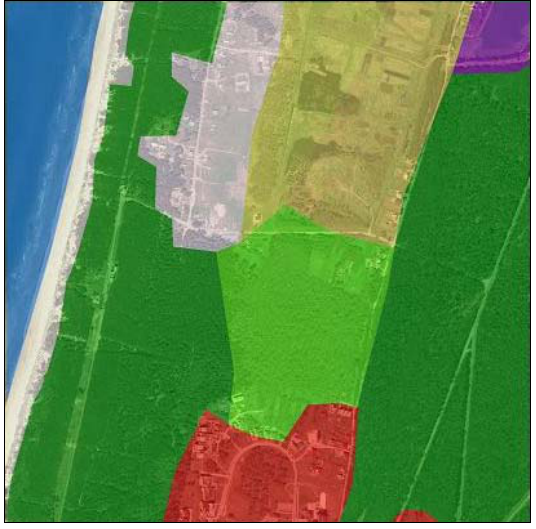
Fig. 6. The patchiest sample (No 96) selected from river valley landscape type (17 land cover patches, 7 types, located in Utena district). This sample represents a geosystem with low buffer potential